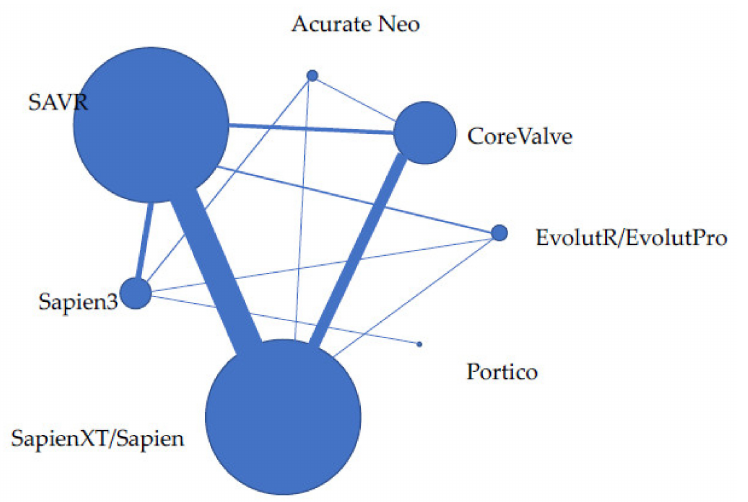
Figure 3. Network diagram of various TAVI valves and SAVR for all-cause mortality. The size of the nodes is proportional to the number of individuals assigned to each valve and the thickness of the lines to the number of direct comparisons in